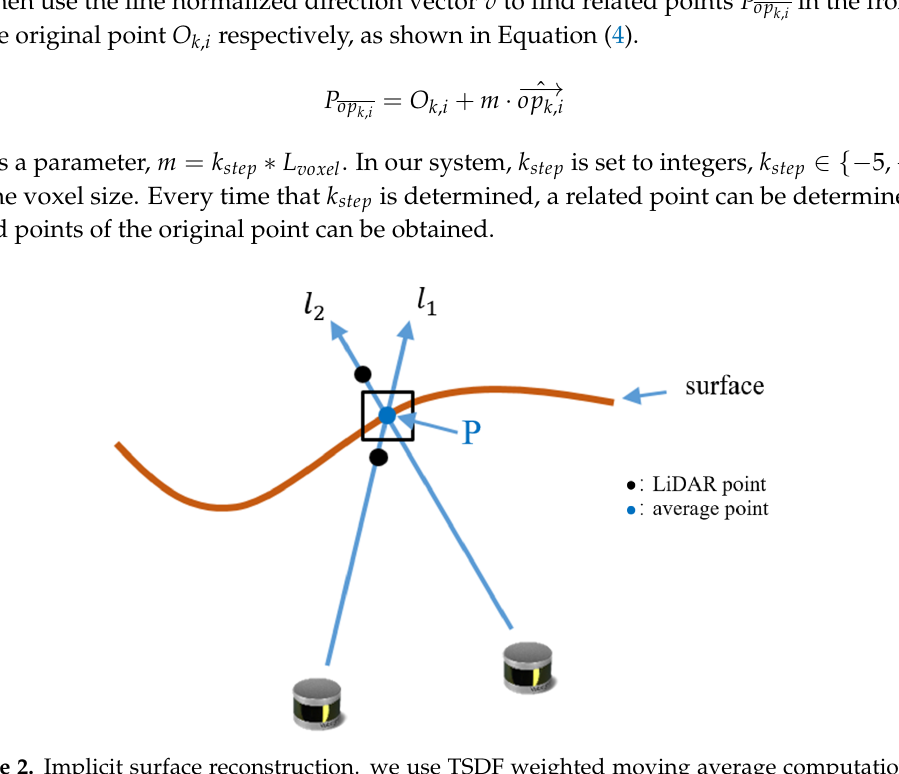
Figure 2. Implicit surface reconstruction. we use TSDF weighted moving average computation. l 1 and l 2 are different lines of sight. The first update l 1 and the next update l 2 combine to get an average surface point, which is close to the real